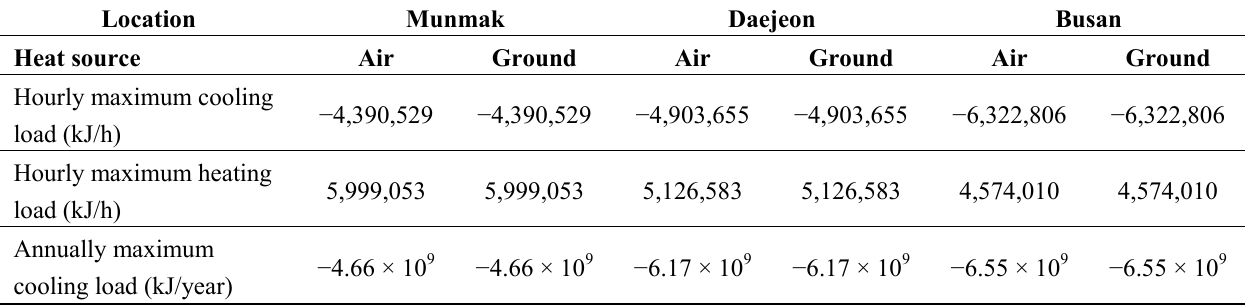
Table 5. Heat pump system simulation results for heating and cooling a resort